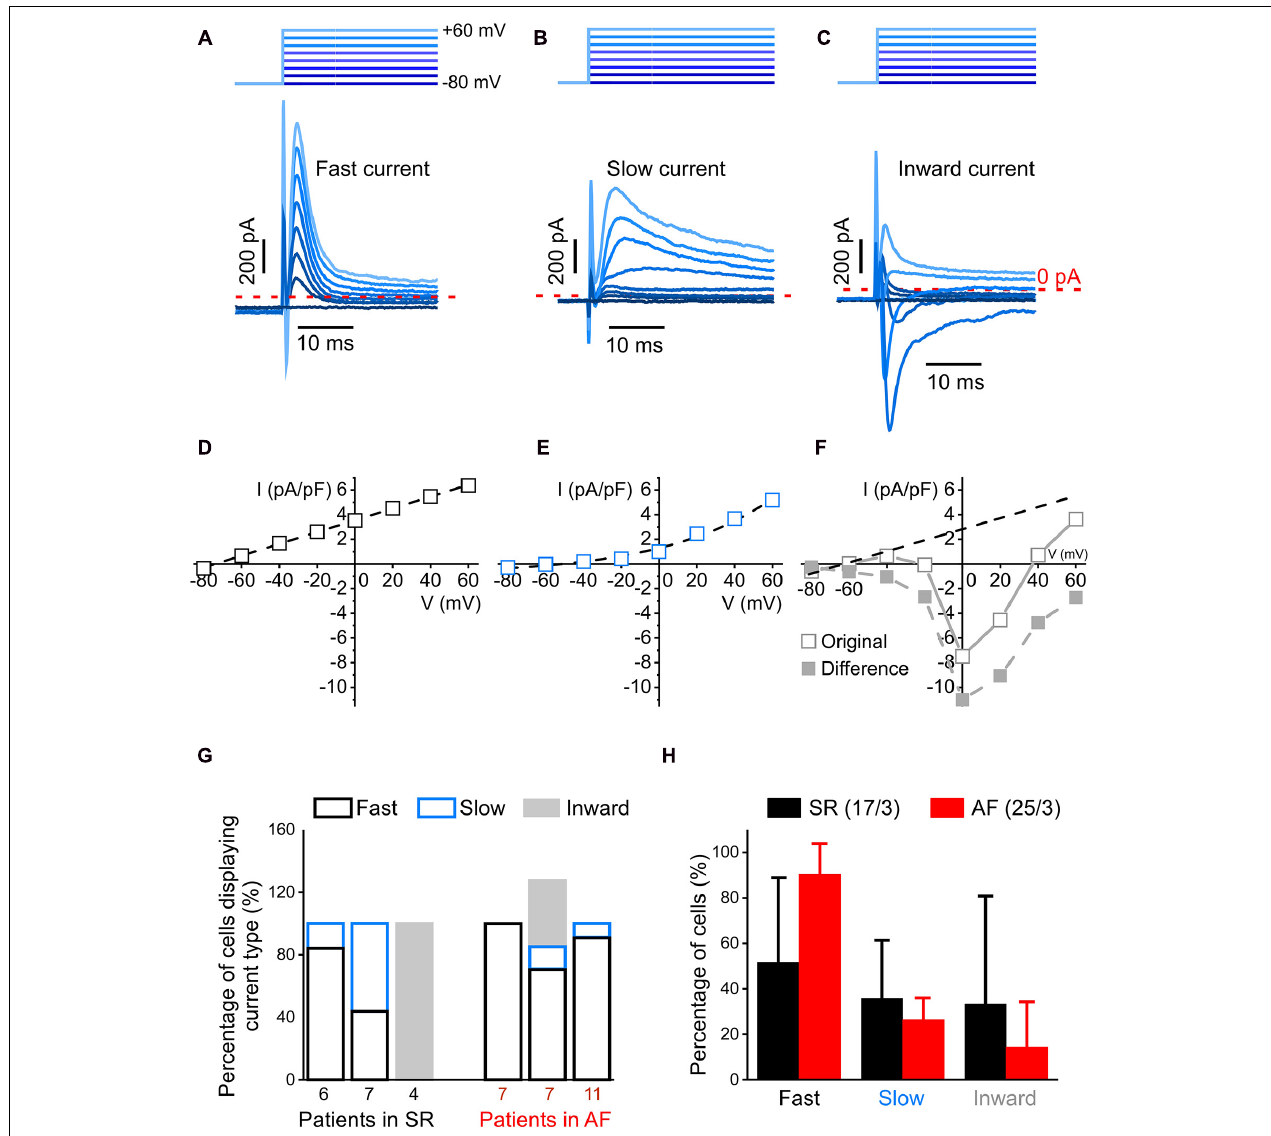
FIGURE 2 | Currents profiles with fast kinetics identifiable with a step-pulse protocol (whole-cell mode). (A–C) : Representative recording of three different current profiles measured during the first 30 ms after depolarization: rapidly activating and inactivating transient outward current (fast current, (A) , more slowly activating and inactivating outward current [slow current, (B) ] and inward current observed at holding potentials ranging from –20 to +60 mV (C) . 1 s-long voltage clamp pulses were used to depolarize cells from –80 to +60 mV in steps of 20 mV; the holding potential used between pulses was –80 mV (top schematic). (D–F) Representative IV curves of peak current. In panel (F) , the difference current IV curve was obtained by subtracting from the original IV curve the one of the fast current (D) . (G) Distribution of current profiles within cells from three patients each with SR and AF. Note that percentages may add up to > 100% because some cells presented two current activation patterns. (H) Comparison of the percentage of cells exhibiting fast and slow outward, and inward current in all cells analyzed from patients with SR and AF. No statistically significant differences in the distribution of current profiles between cells from SR and AF patients were